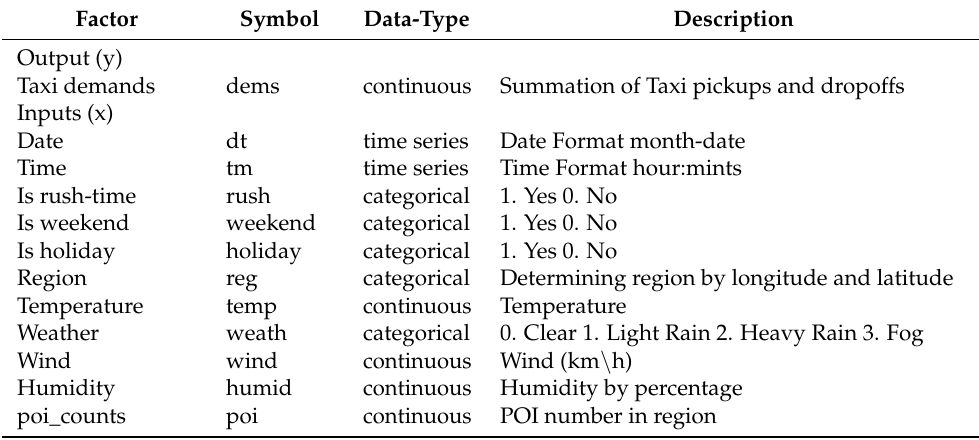
Table 4. Features in the